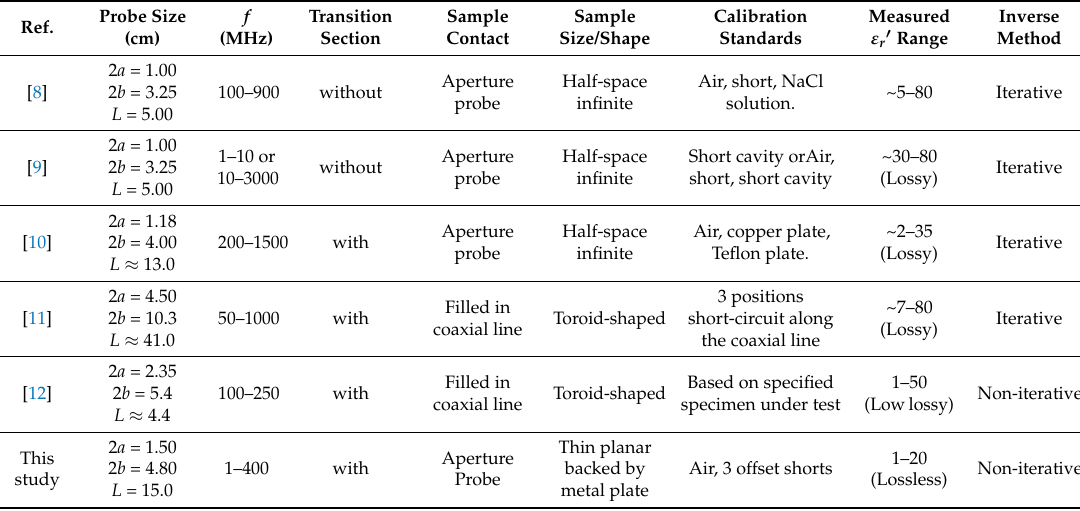
Table 1. Comparative study of large